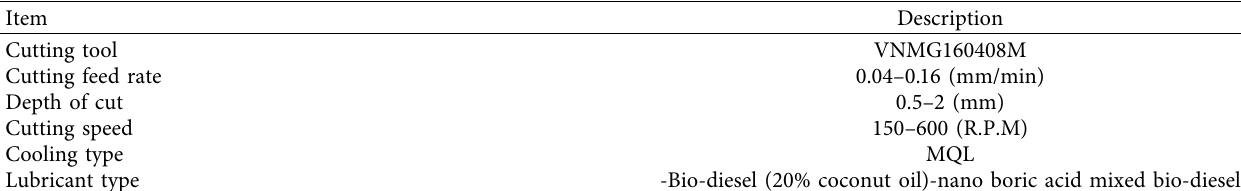
Table 5: Experimental input parameters.